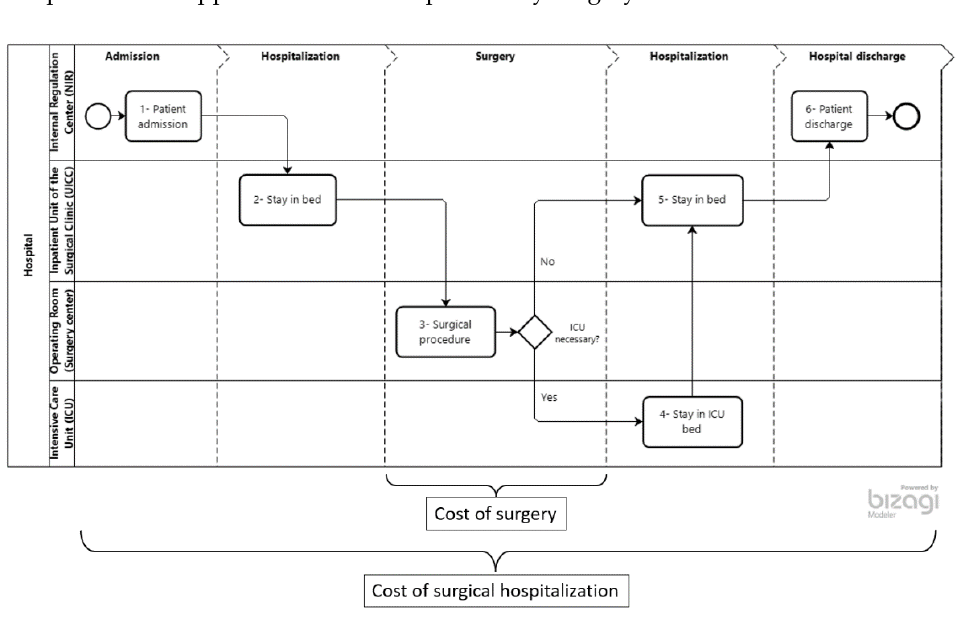
Figure 2. Flow of surgical hospitalization and scope of the study (cost of surgical hospitalization).